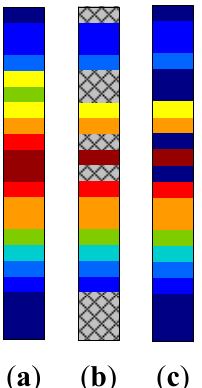
Figure 5. An example of RSS reading collected in green WLAN, where some RSS reading vector missing its entry value in the online phase. ( a ) Ideal RSS vector; ( b ) Sensed RSS vector; ( c ) Recorded RSS